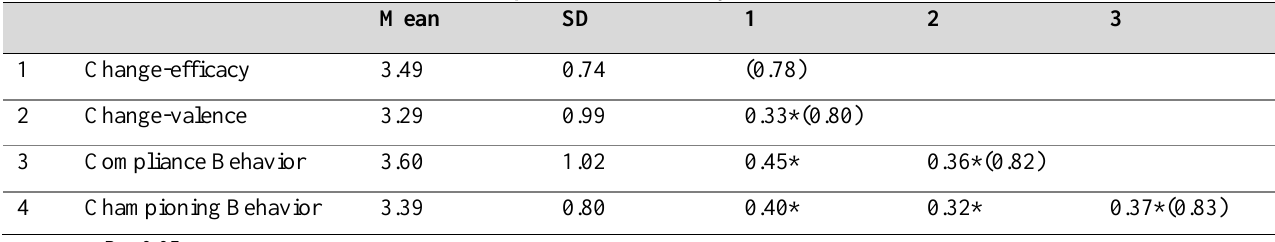
Descriptive and Reliability